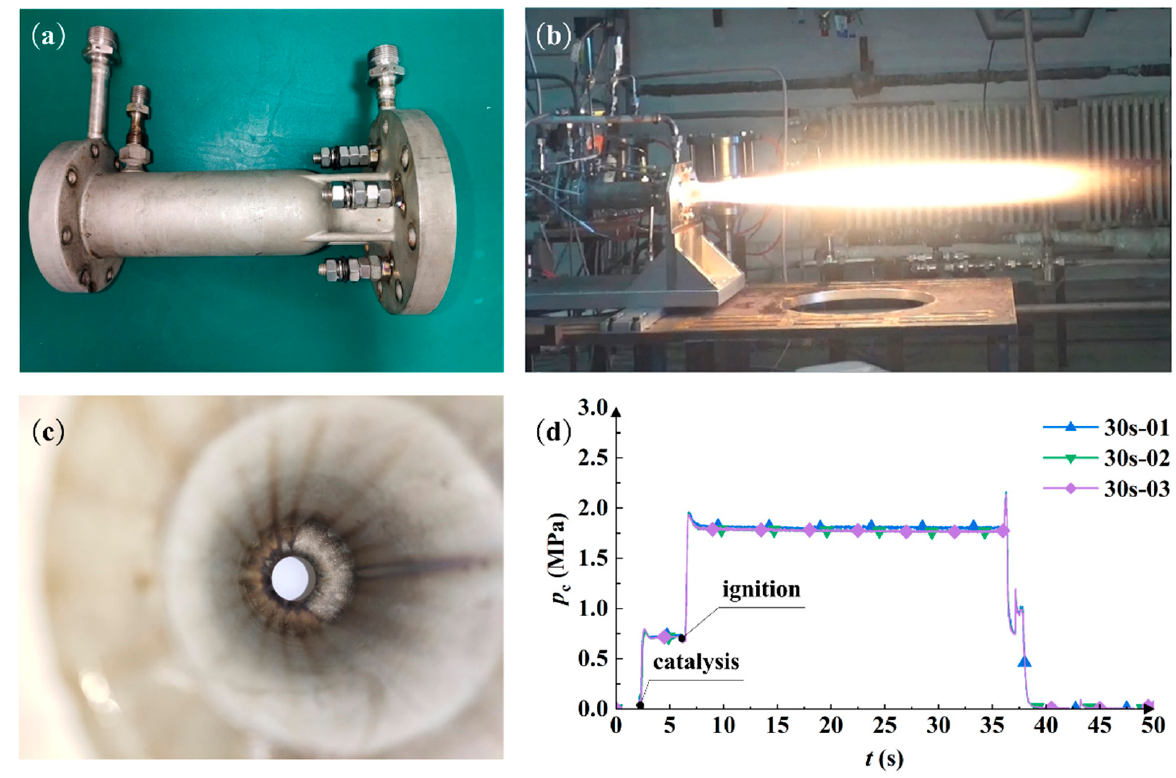
Figure 9. Catalysis and ignition experiments of the hydrogen peroxide and kerosene engine with regeneration cooling. ( a ) The hydrogen peroxide and kerosene engine; ( b ) the ignition of hydrogen peroxide and kerosene; ( c ) the inner wall of the thrust chamber after ignition from the nozzle outlet towards the injector; ( d ) the combustion chamber pressure under different experiment conditions. Table 3. The experiment and simulation of the heat flux at the throat of thrust